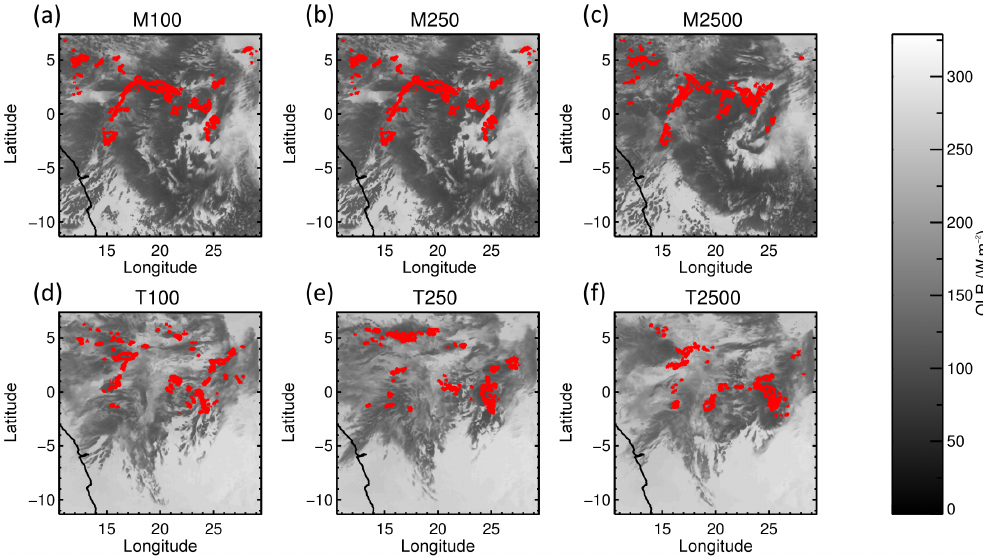
Figure 1. Congo case: instantaneous outgoing longwave radiation (Wm 2 , greyscale) and 5mmh − 1 surface precipitation rate (red contour) at 07:00UTC on 7 August 2007 in the Congo basin configuration. (a–c) CONGO-MORR simulations and (d–f) CONGO-THOM simulations. Prescribed CDNC values of 100, 250 and 2500cm − 3 are shown in panels (a, d) , (b, e) and (c, f) ,